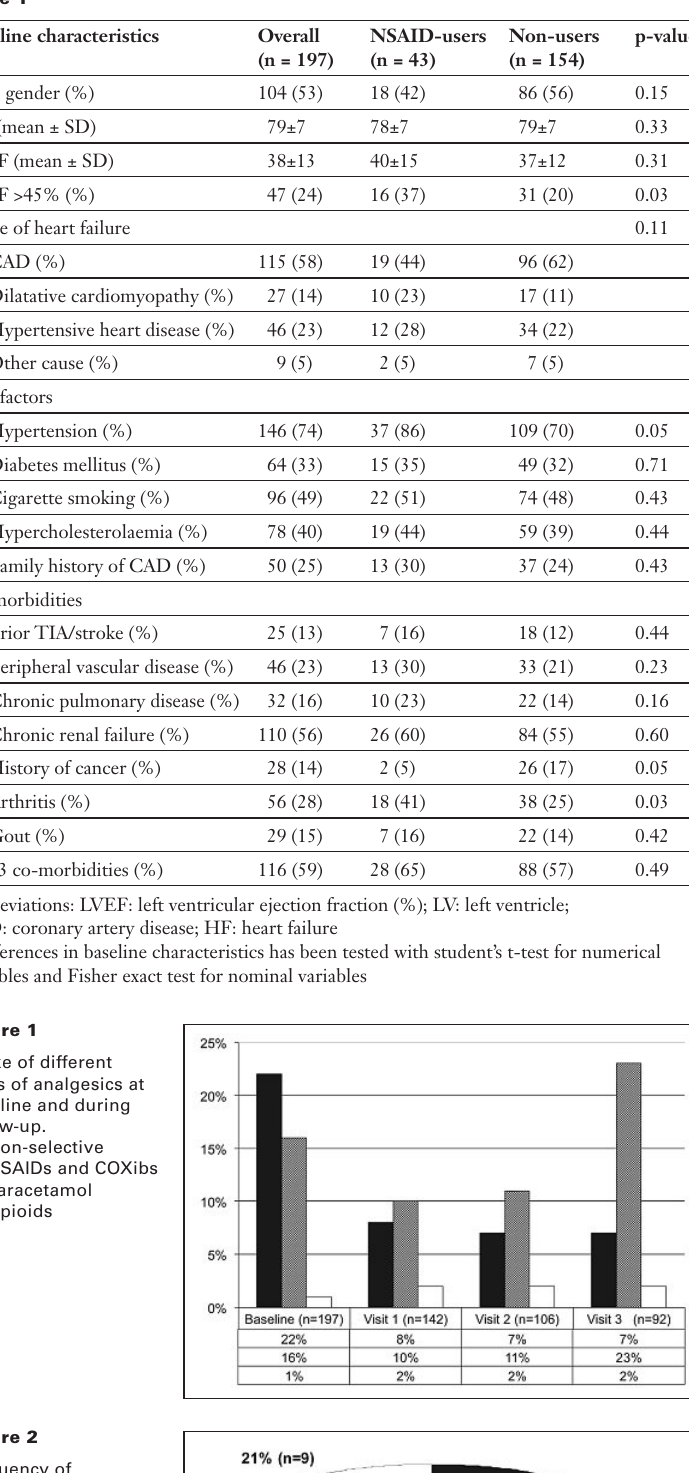
Frequency of NSAID intake.